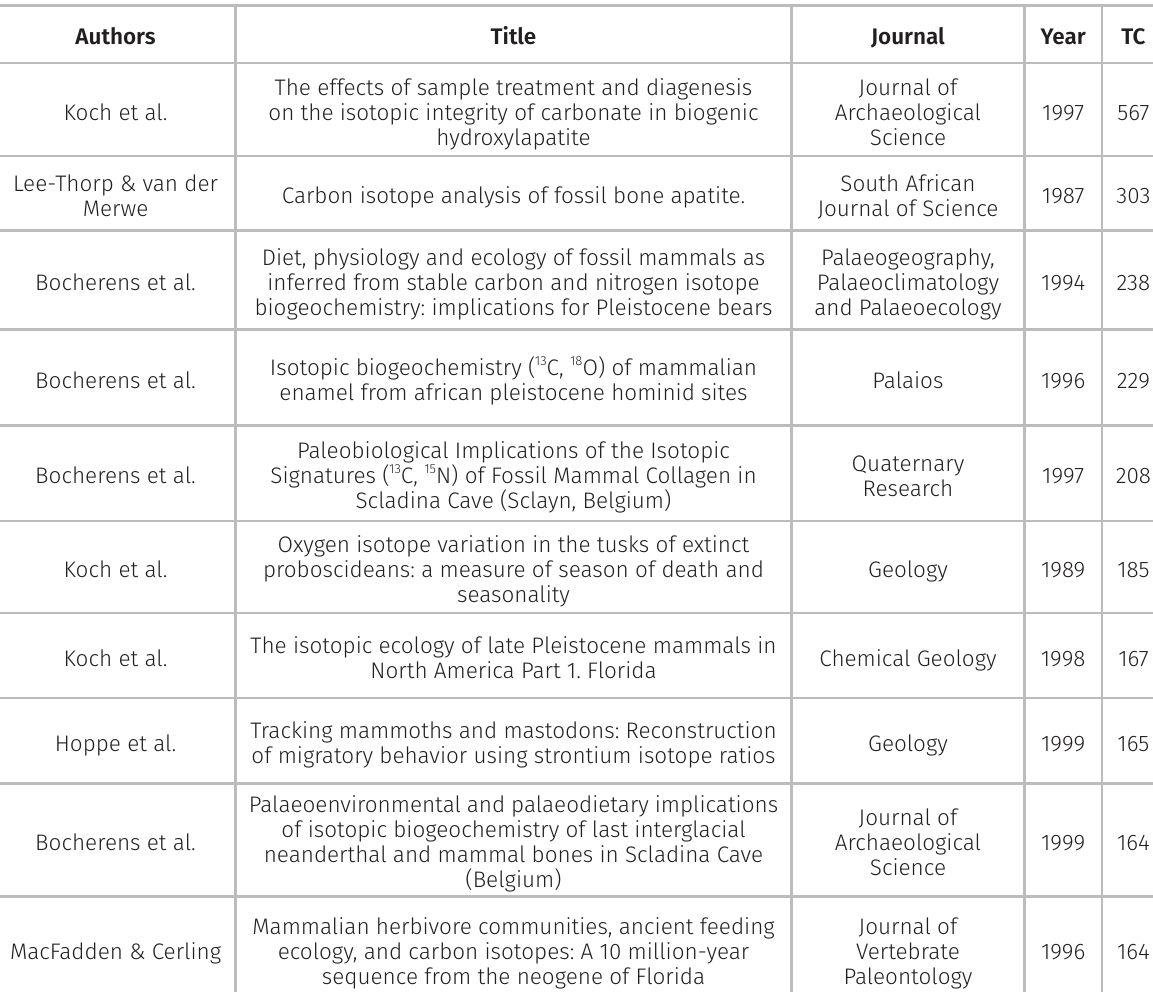
Table II. Top ten most cited articles within the Scopus platform. Legend: TC (Total Citation in Scopus). Authors The effects of sample treatment and diagenesis on the isotopic integrity of carbonate in biogenic hydroxylapatite Carbon isotope analysis of fossil bone apatite. Diet, physiology and ecology of fossil mammals as Bocherens et al. inferred from stable carbon and nitrogen isotope biogeochemistry: implications for Pleistocene bears Isotopic biogeochemistry ( 13 C, 18 O) of mammalian Bocherens et al. enamel from african pleistocene hominid sites Paleobiological Implications of the Isotopic Bocherens et al. Signatures ( 13 C, 15 N) of Fossil Mammal Collagen in Oxygen isotope variation in the tusks of extinct Koch et al. proboscideans: a measure of season of death and seasonality The isotopic ecology of late Pleistocene mammals in Koch et al. North America Part 1. Florida Tracking mammoths and mastodons: Reconstruction Hoppe et al. of migratory behavior using strontium isotope ratios Palaeoenvironmental and palaeodietary implications of isotopic biogeochemistry of last interglacial Bocherens et al. neanderthal and mammal bones in Scladina Cave (Belgium) Mammalian herbivore communities, ancient feeding MacFadden & Cerling ecology, and carbon isotopes: A 10 million-year sequence from the neogene of